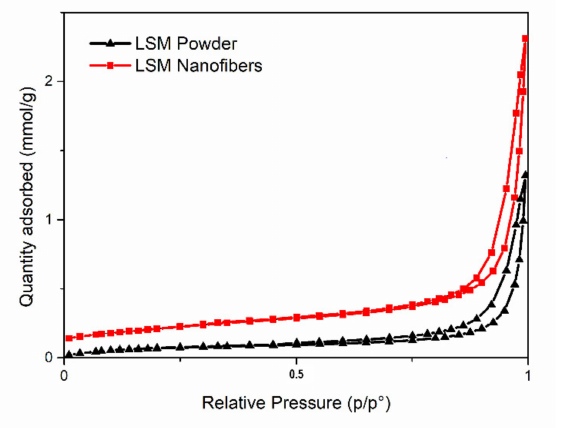
Figure 6. N 2 -adsorption and desorption isotherms for LSM powders (black) and nanofibers (red).